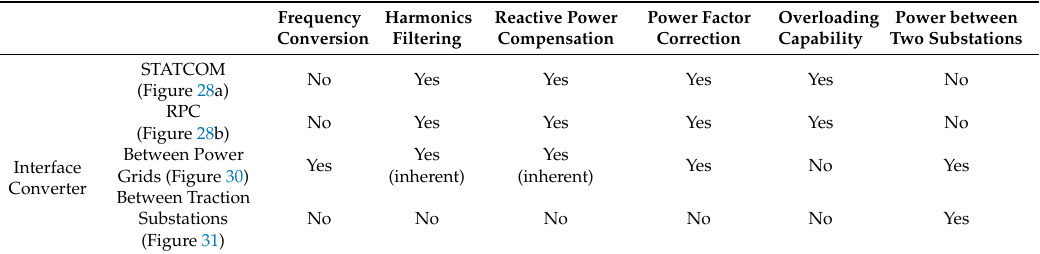
Table 6. Capabilities of power electronics converters used in railway fixed applications (in